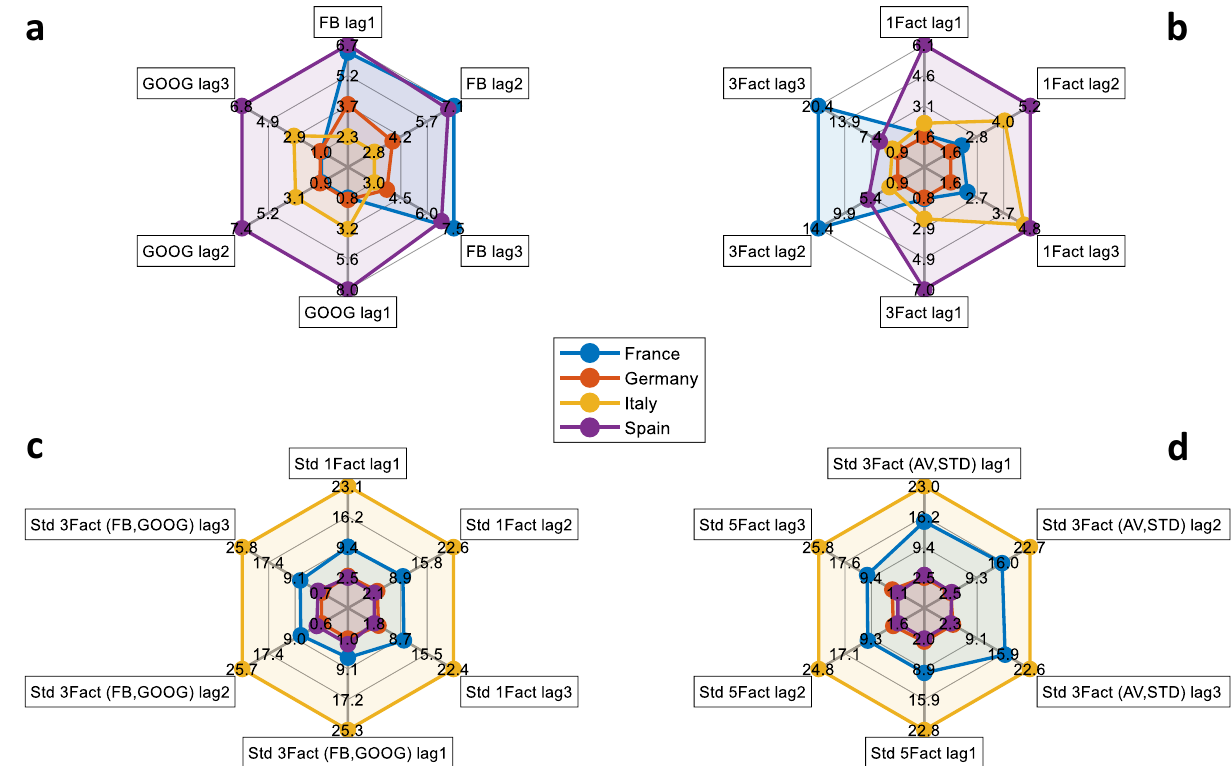
Figure 8. Spider-plots of the model selection results. The figure shows the spider-plots of the values of the mean squared error (MSE) for different types of model configurations, across the four countries. ( a ) shows the MSEs of the models with either Facebook (FB) or Google (GOOG) average mobility data and varying number of lags of the predictors from 1 to 3. ( b ) illustrates the MSEs of the models obtained by including both dataset with either 1 or 3 factors and different number of lags of the predictors from 1 to 3. ( c ) shows the MSEs of the models with either 1 or 3 factors including the time series standard deviations and different number of lags of the predictors from 1 to 3. Finally, ( d ) shows the MSEs of the models with either 3 or 5 factors including the time series standard deviations and different number of lags of the predictors from 1 to